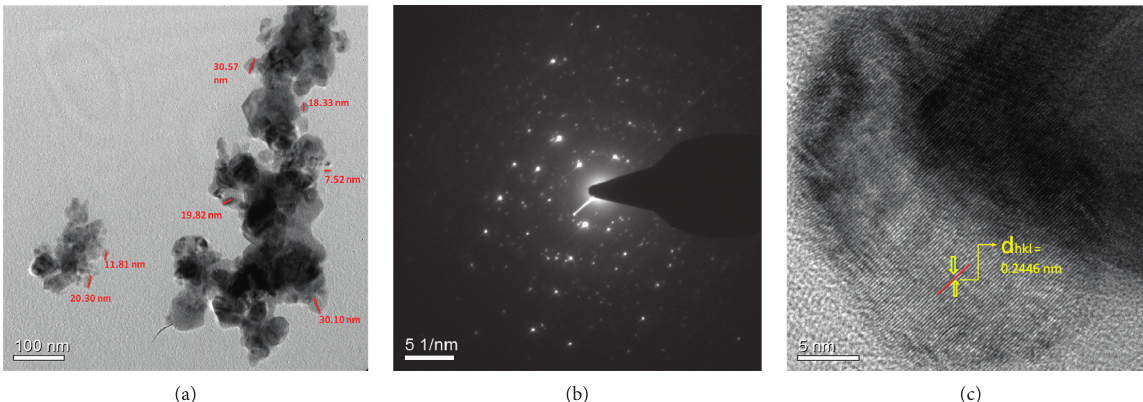
Figure 5: (a) TEM image, (b) SAED pattern, and (c) HRTEM image of biosynthesized ZnO NPs from zinc acetate dihydrate and leaf extract of Lippia adoensis in 1:1 ratio by volume.